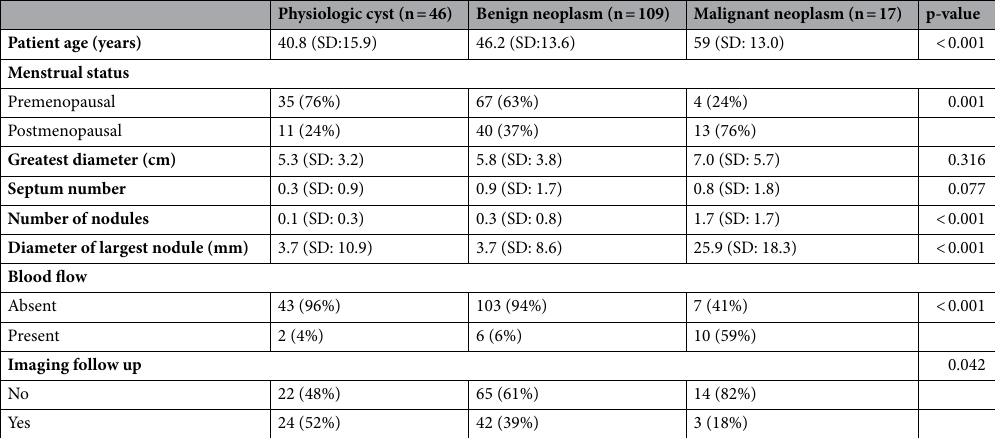
Table 3. Patient and imaging characteristics of adnexal masses with histologic confirmation of diagnosis (n = 172). Of the patients with pathologic confirmation of their diagnosis, increasing age (p ≤ 0.001), postmenopausal status (p = 0.001) and elevated CA125 (p = 0.001) were more likely to be malignant. Mass size and number of septa were not significant predictors of malignancy (p = 0.301 and p = 0.063 respectively). Number of nodules (p < 0.001) and the size of the largest nodule present (p < 0.001) were both predictive of malignancy. Of note, ‘septum number’ and ‘number of nodules’ were not evenly distributed, and the median values across all three categories are zero. Mean values are provided within the table to provide a non-zero comparison between groups.